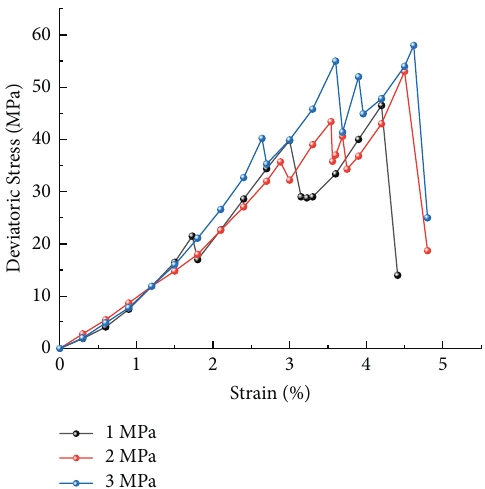
Figure 14: Variation curve of peak strength and residual strength of specimen with confining pressure. Table 4: Triaxial compression test of fine sandstone specimens with different confining pressures.